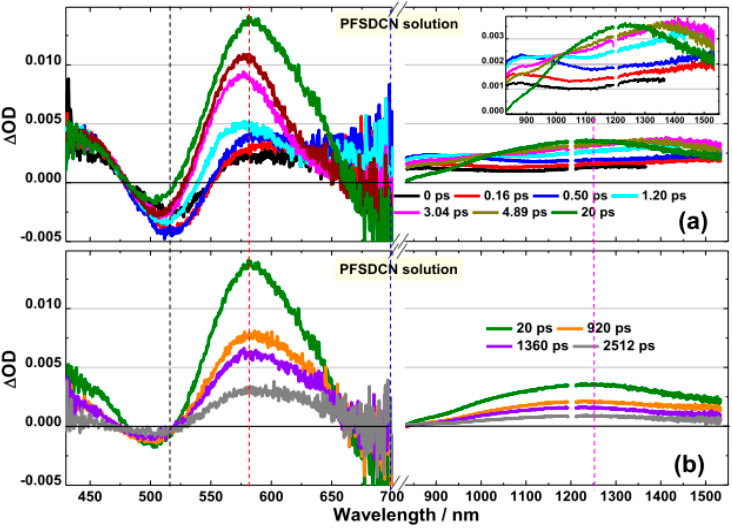
Figure 4. Transient absorption spectra of PFSDCN in chlorobenzene solution with excitation wavelength at 400 nm (6.30 × 10 13 photons·cm − 2 ·pulse − 1 ). ( a ) Spectra at first 20 ps and ( b ) spectra at 20